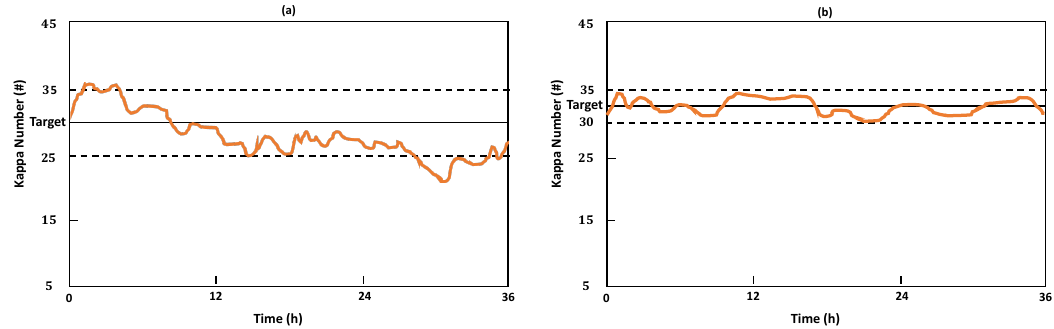
Figure 9. Graph showing Kappa number variability: ( a ) before and ( b ) after improved control.